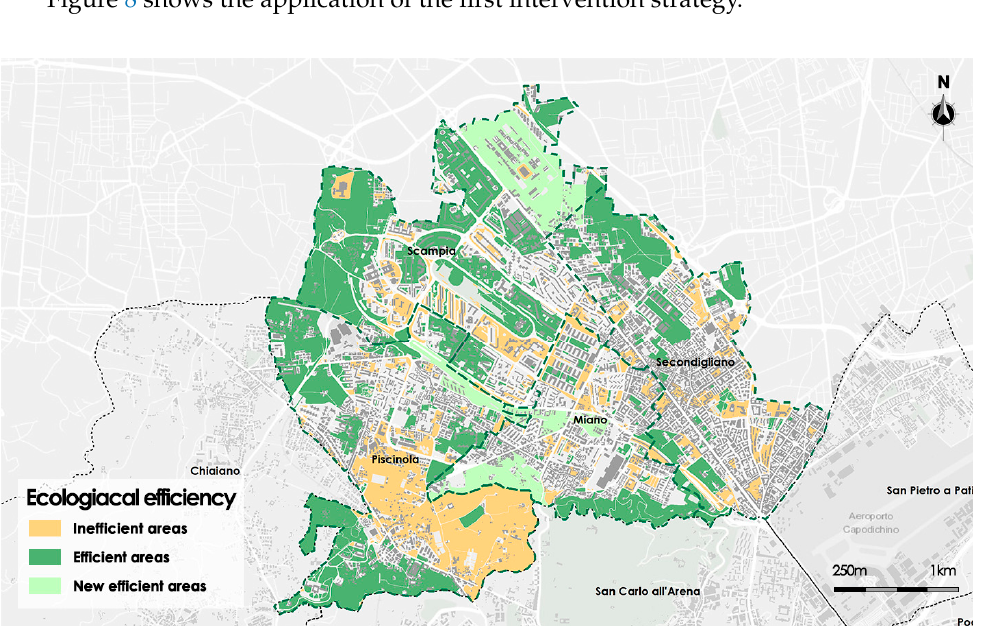
Figure 8. Distribution of ecologically efficient areas after the first intervention strategy.